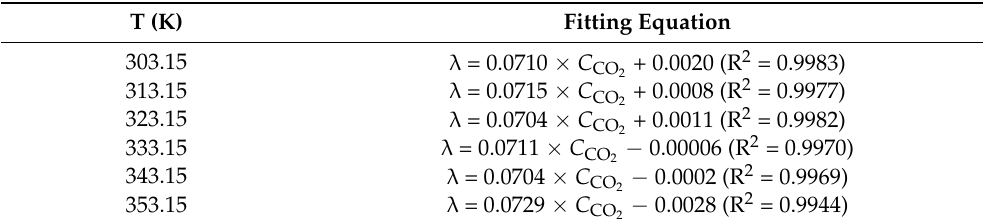
Table 6. The standard curve relationship between CO 2 concentration and the Raman peak intensity ratio of CO 2 + n -decane system.